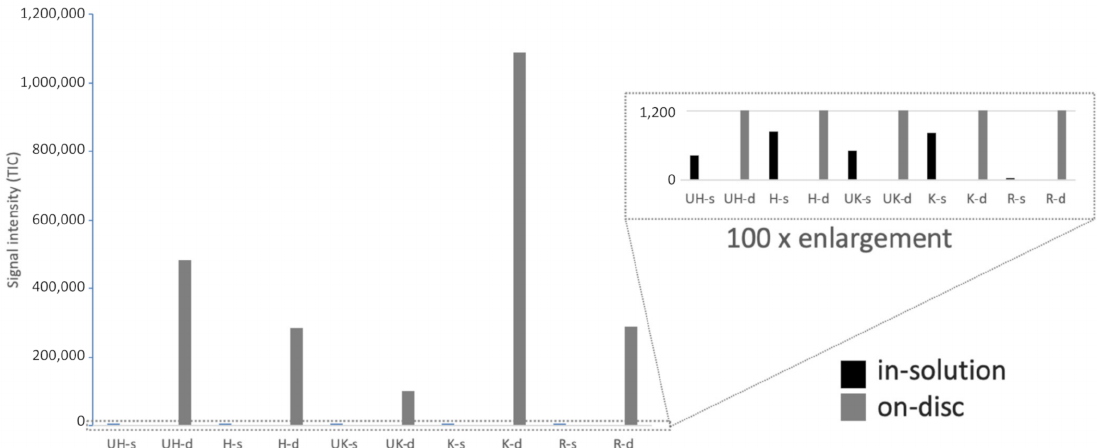
Figure 6. Signal intensity of MIFAGIK. UH: untreated paper, trypsin immobilized for 3 h. H: HEMA-VDM-functionalized paper, trypsin immobilized for 3 h. UK: untreated paper, trypsin immobilization o/n. K: KIO 4 -functionalized paper, trypsin immobilization o/n. R: KIO 4 -functionalized paper, trypsin immobilization o/n followed by reduction. -s: in- solution digestion, -d: on-disc digestion.